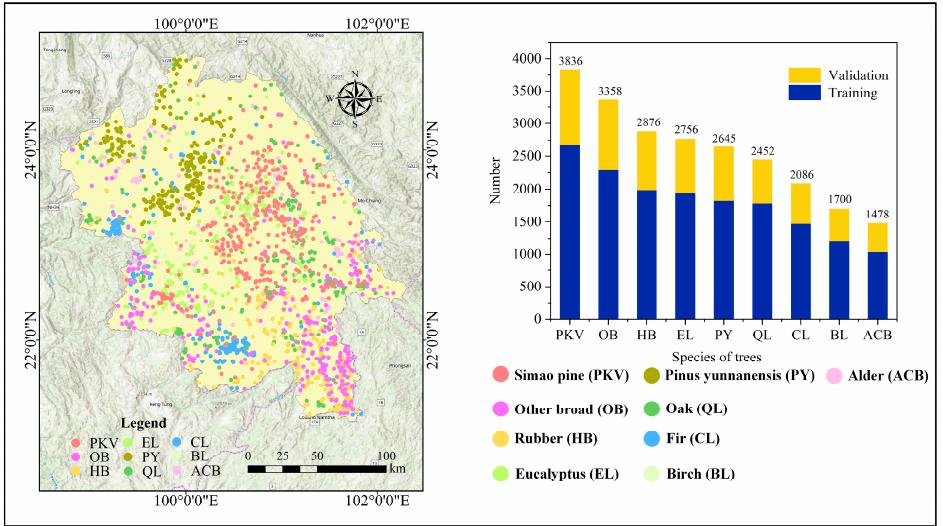
Figure 2. Spatial distribution and counts of field reference data points. Table 2. Different data cases are designed for tree species